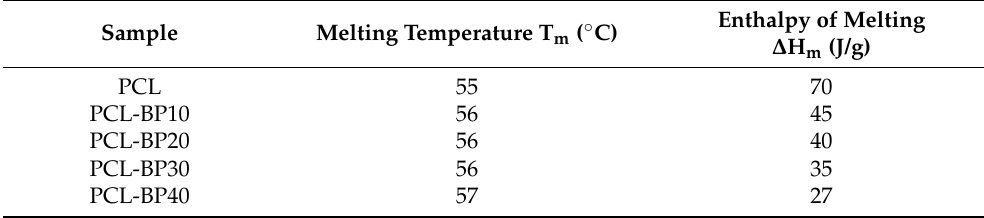
Table 3. Melting temperature (T m ) and enthalpy of melting ( ∆ H m ) of PCL-BP